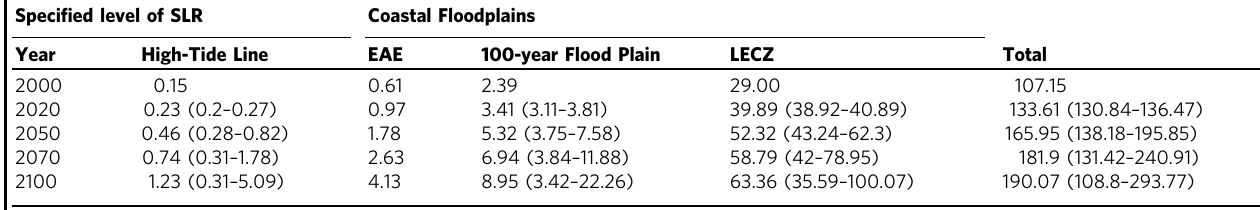
Table 1 Projected populations affected in all 406 coastal counties exposed across four spatio-temporal zones between 2000 and 2100 under Shared Socioeconomic Pathway 2 (SSP) and Representative Concentration Pathway 4.5 (RCP) in